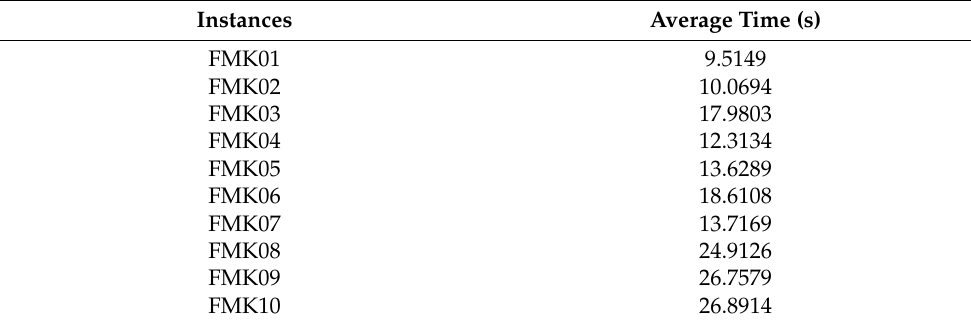
Table 3. The average calculation time of each benchmark.